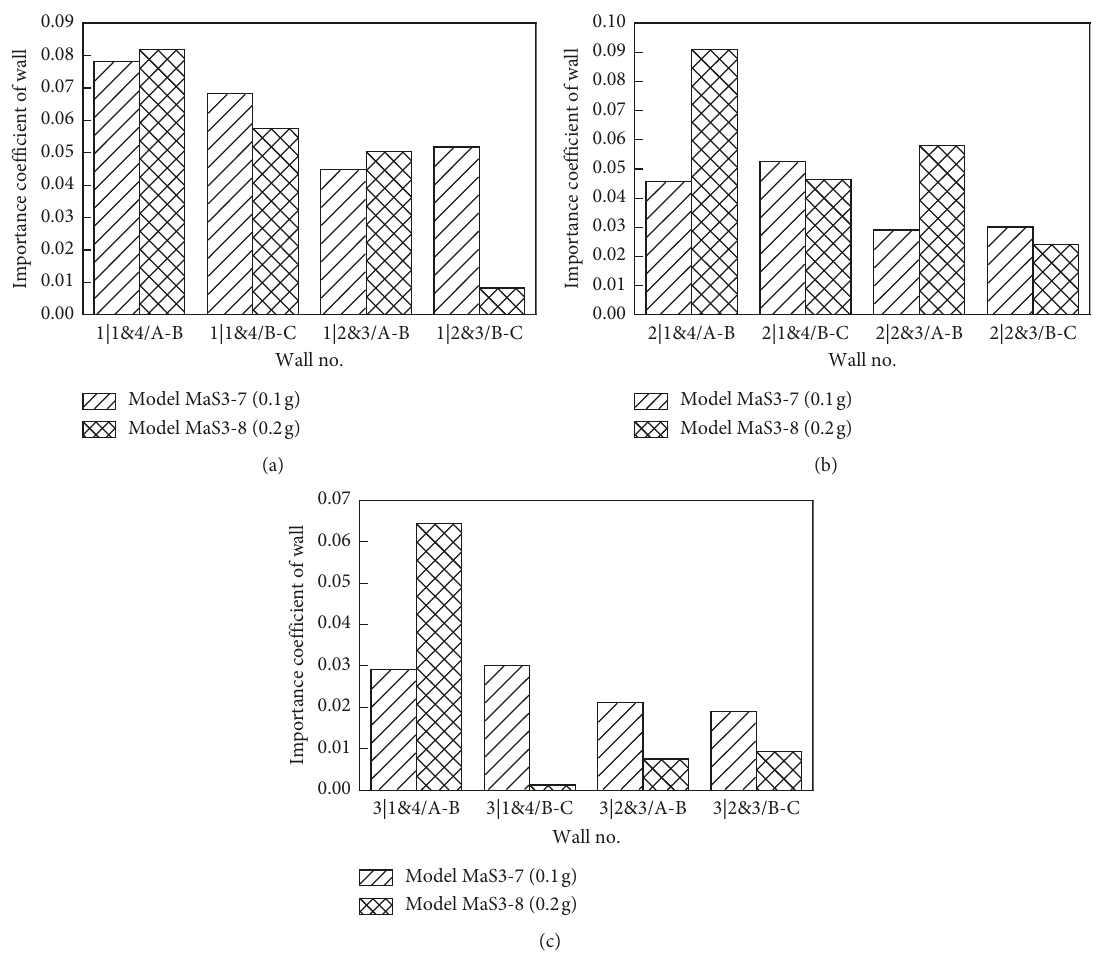
Figure 10: Importance coefficient of different fortification intensity structure wall. (a) 1st floor. (b) 2nd floor. (c) 3rd